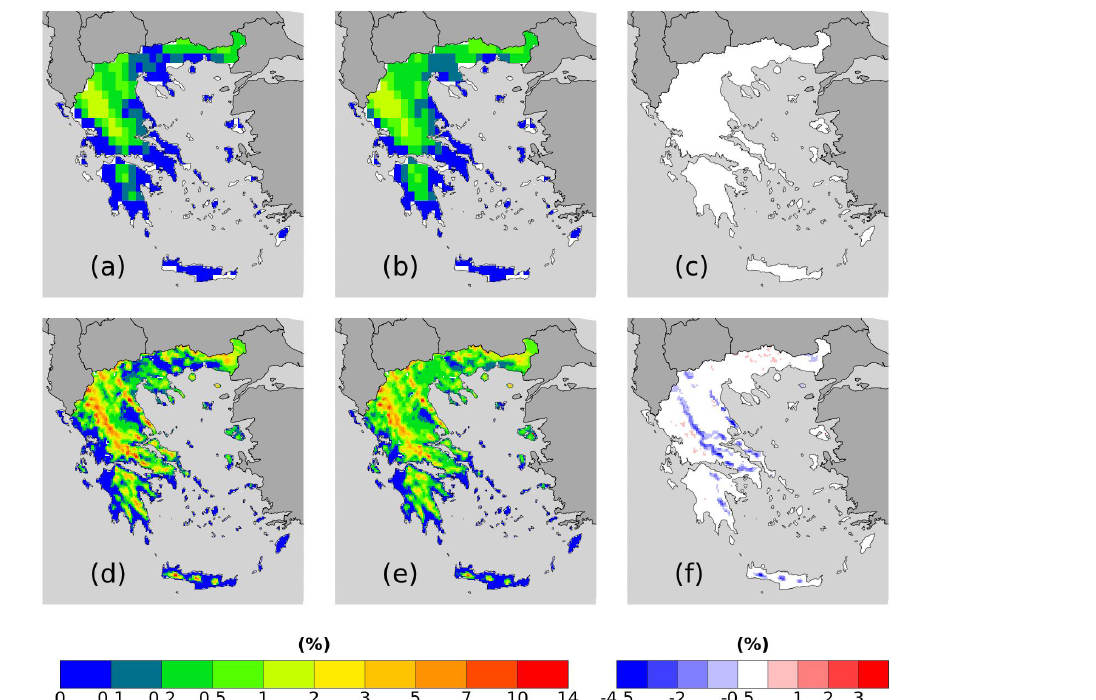
Figure 6. RR20FD probabilities for (a–c) ERA5 and (d–f) WRF_ERA_I produced by (a, d) empirical and (b, e) copula and = (b) – (a) and (f) = (e) – (d) .